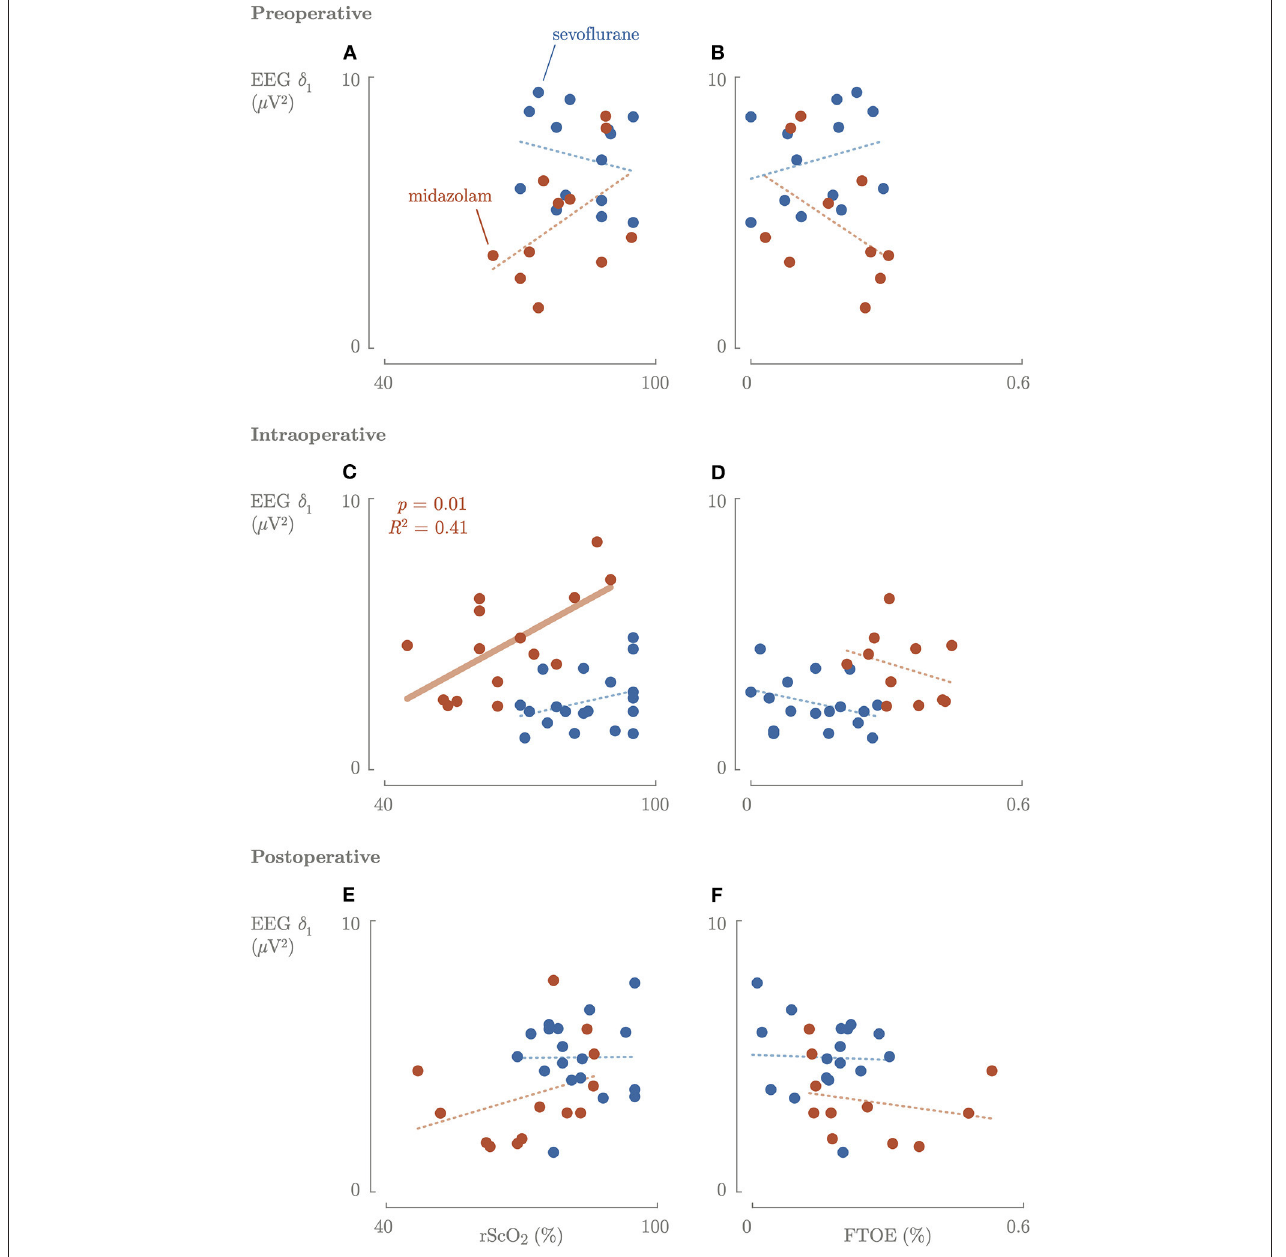
FIGURE 4 | Correlation between the cerebral activity and cerebral oxygenation and oxygen consumption preoperative (A,B) , intraoperative (C,D) , and postoperative (E,F) . Blue, sevoflurane group; red, midazolam group; fat line, significant